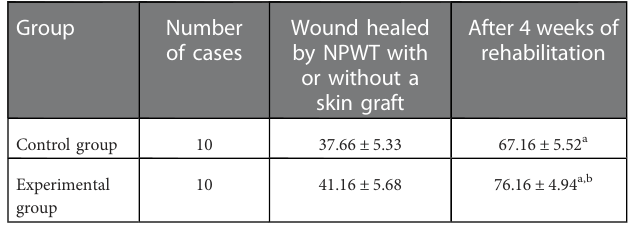
TABLE 3 Comparison of bMHQ scores ð (cid:1) x + s Þ . Group Number Wound healed of cases by NPWT with or without a skin